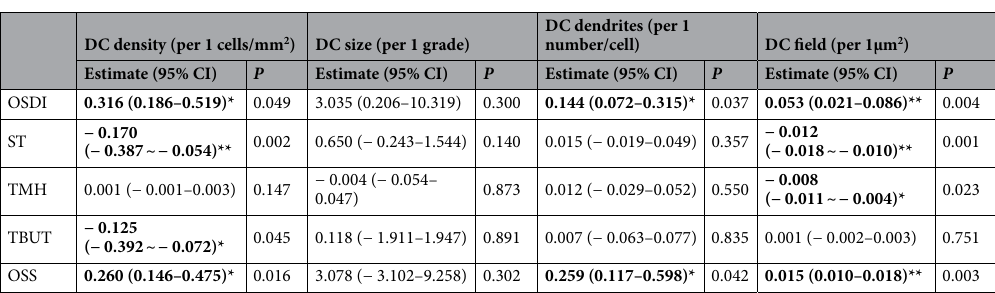
Table 4. Multivariate linear regression models: associations between DC parameters and ocular features in SSDE. DC dendritic cell, SSDE Sjogren’s syndrome dry eye, OSDI ocular surface disease index, ST Schirmer’s test, TMH tear meniscus height, TBUT tear film breakup time, OSS ocular staining score, CI confidence interval. The Estimate (95% CI) is shown for all significant correlations in bold. * P < 0.05.